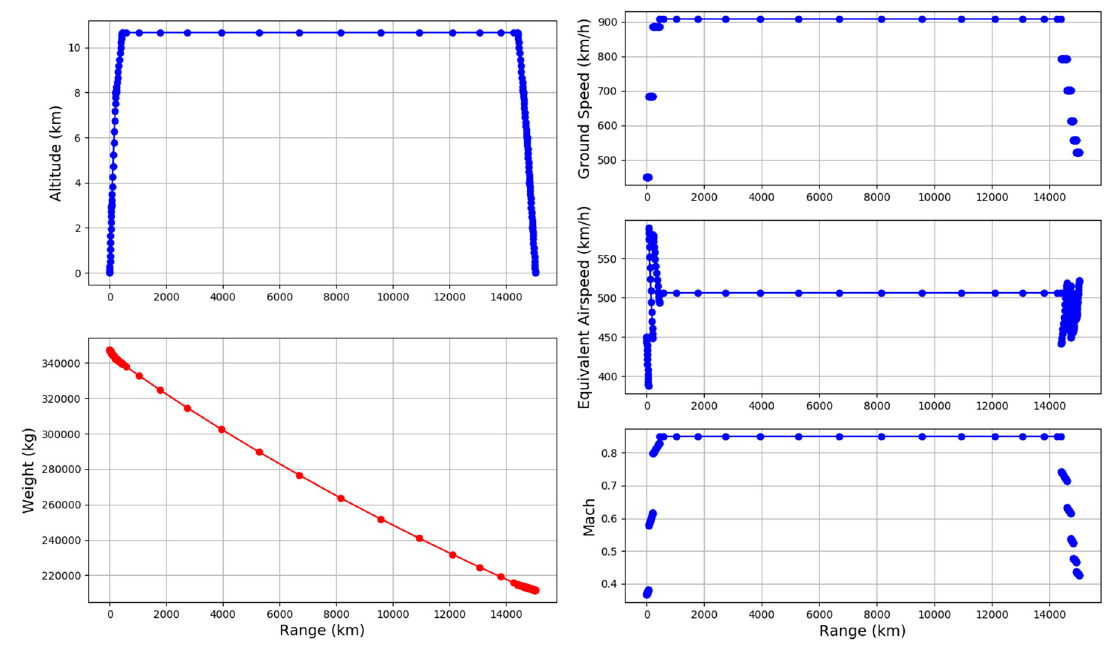
Figure A2. Mission performance of B777.